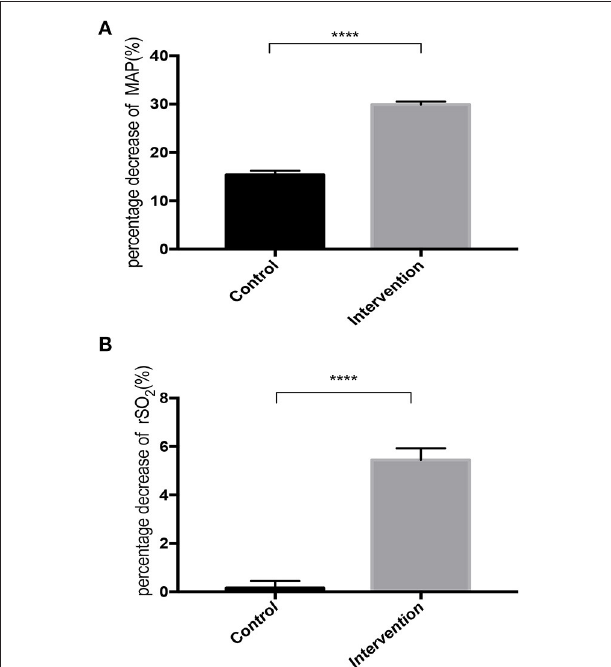
FIGURE 3 | Percentage decrease in MAP (A) and rSO 2 (B) during deliberate hypotension in control and intervention groups. Filled square with error bars represent the mean and SE of mean. **** P < 0.0001 vs. control group.